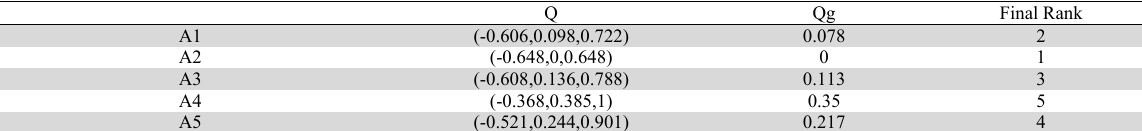
Index Qi and final